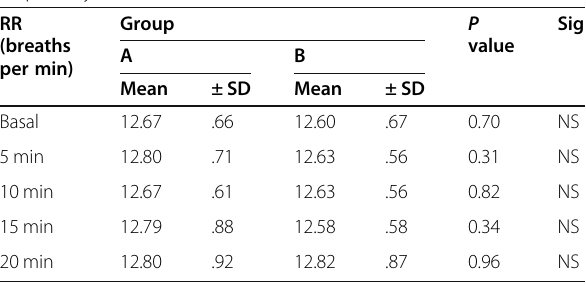
Table 5 Comparison between group A and B as regards respiratory rate